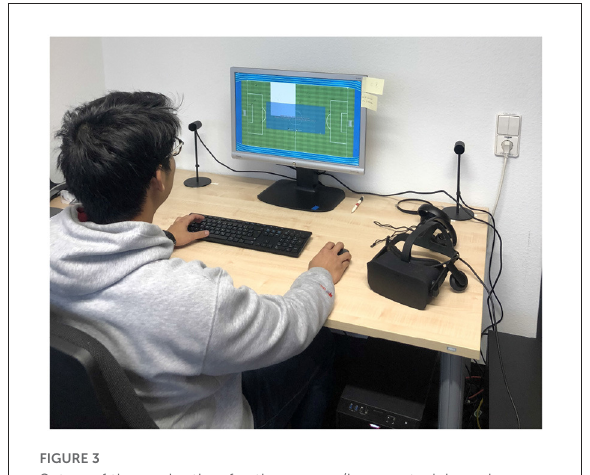
FIGURE3 Setup of the evaluation for the mouse/key control-based application used by one of the